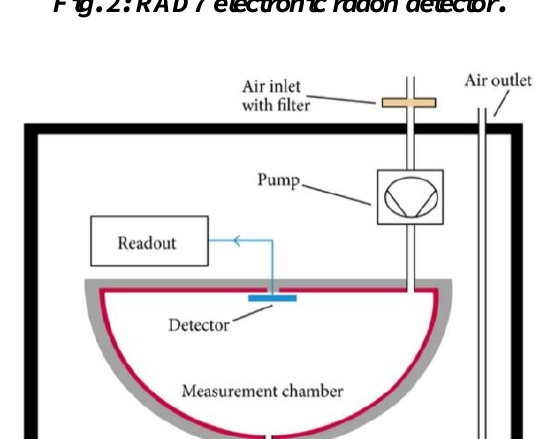
Fig. 2: RAD7 electronic radon detector.